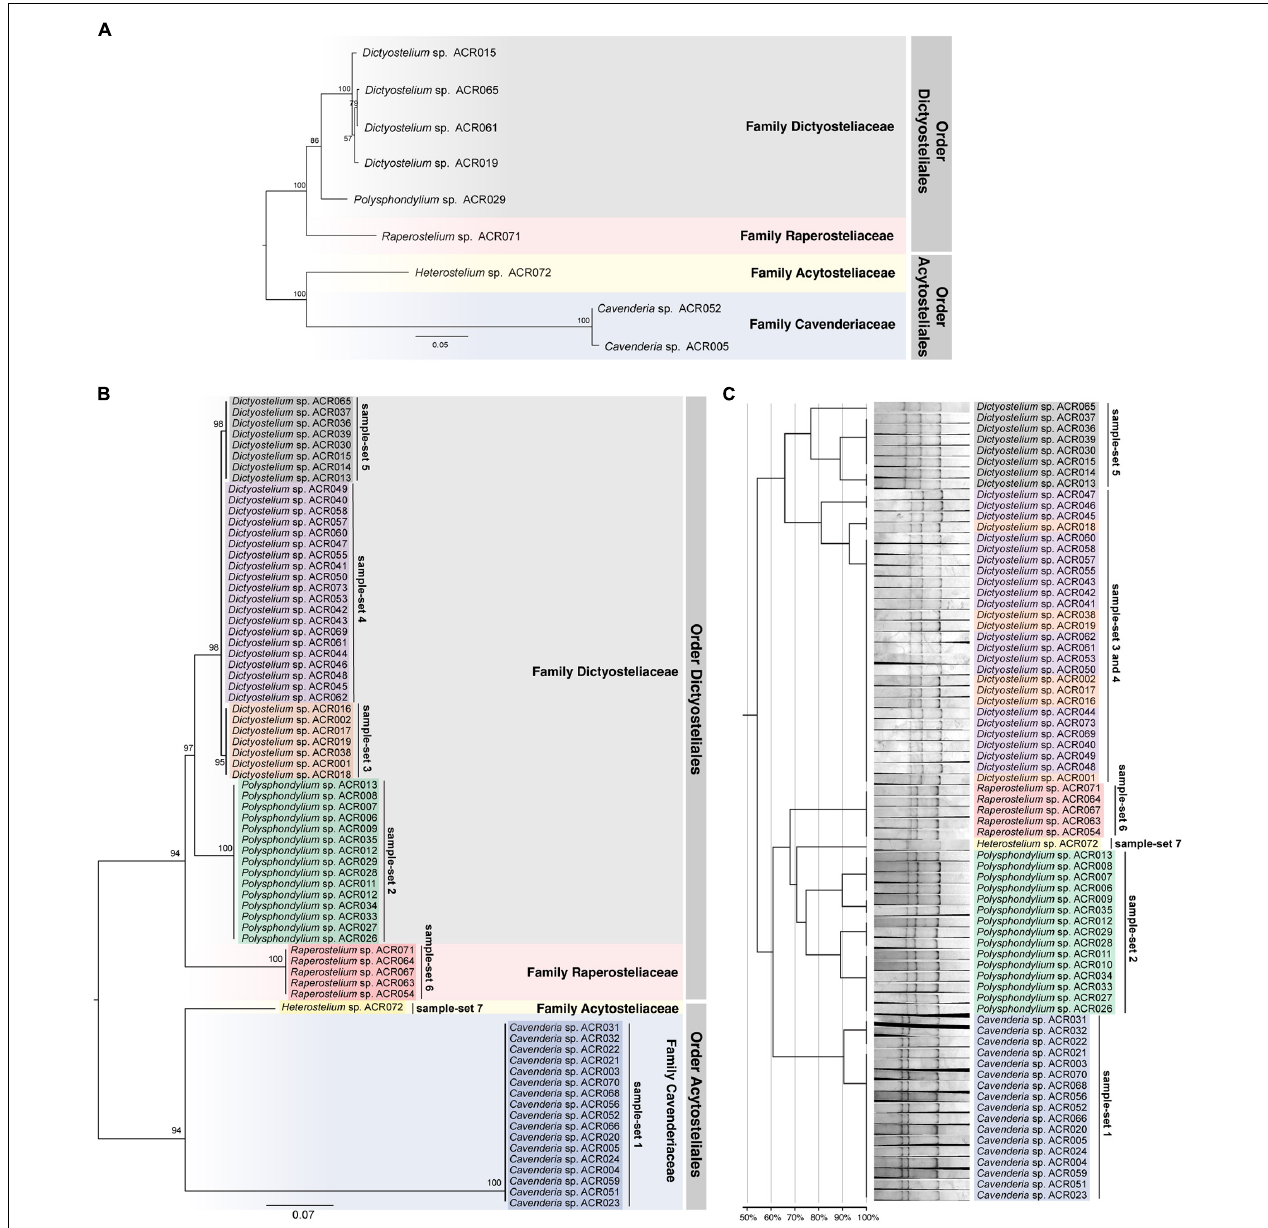
FIGURE 5 | Comparison between the maximum likelihood (ML) phylogenies and the clustering of the single-strand conformation polymorphism (SSCP) fingerprint patterns of all 73 dictyostelid Thai isolates. Molecular phylogeny of the full-length SSU rDNA gene sequences was reconstructed using the ML method of nine representative sequences of dictyostelids (A) . Each branch on the tree was supported by bootstrap analysis with 1,000 replicates of pseudo-samples. The family and order names of dictyostelids were labeled on the right-hand side of the tree. The scale bar indicates the distance value of each branch. Colored boxes represent the families of dictyostelids. The ML phylogeny was reconstructed from ∼ 200-bp PCR-SSCP region of 73 dictyostelid Thai isolates (B) . Sequences in the different sample-sets are highlighted with different colors, including sample-set 1 (blue), sample-set 2 (green), sample-set 3 (orange), sample-set 4 (purple), sample-set 5 (gray), sample-set 6 (red), and sample-set 7 (yellow). Clustering of the SSCP fingerprint patterns of all 73 isolates of Thai dictyostelids was performed using GelJ software (C) . The normalized SSCP fingerprint patterns and taxon labels are illustrated at the right-hand side of the dendrogram. The taxa of the same sample-set are highlighted with the same colors of the ML phylogeny. The scale bar underneath the dendrogram indicates the similarity percentages between each pattern in the dendrogram.